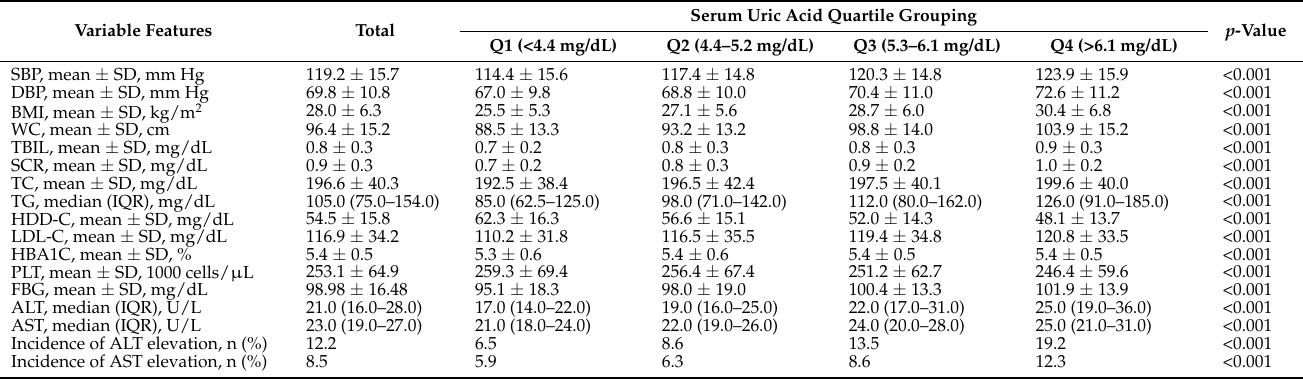
Table 2. Healthcare diagnosis data for study